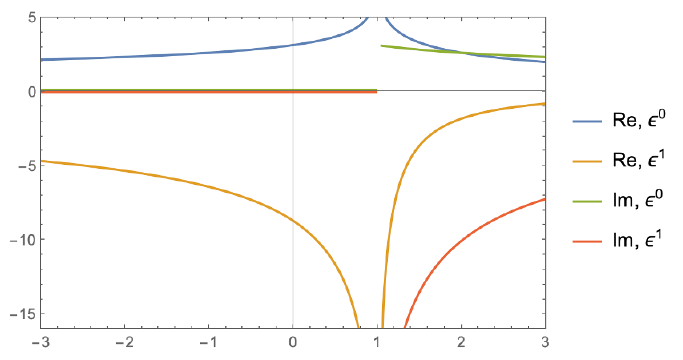
Figure 1. The real and imaginary parts of the (cid:12)rst two orders in the (cid:15) expansion of the master integral T 1